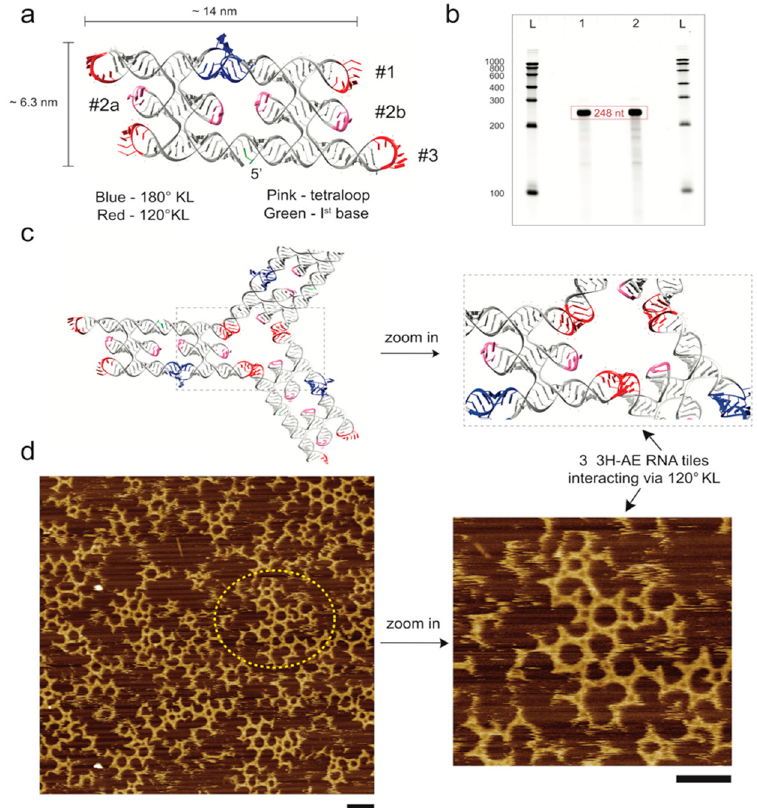
Figure 1. Design and characterization of the 3H-AE RNA tile. ( a ) schematic representation of designed 3H-AE RNA tile. Structural motifs are color coded as described in the legend; ( b ) denaturing PAGE gel showing the correct length of the RNA tile. L: LowRange RiboRuler, 1-2: RNA tile transcribed from DNA template amplified from Phusion High-Fidelity Master mix with HF or GC, buffer, respectively. ( c ) 3H-AE RNA tiles can interact with each other via 120° kissing loop (KL) motifs; ( d ) AFM images showing correct assembly and interaction of the RNA tiles. Tile assemblies were prepared by snap-cooling followed by incubation on mica at 37 °C (cf. Materials and Methods). The region enclosed by the dashed circle is further zoomed in to show the interactions of the 120° KL. Scale bars: 50 nm.